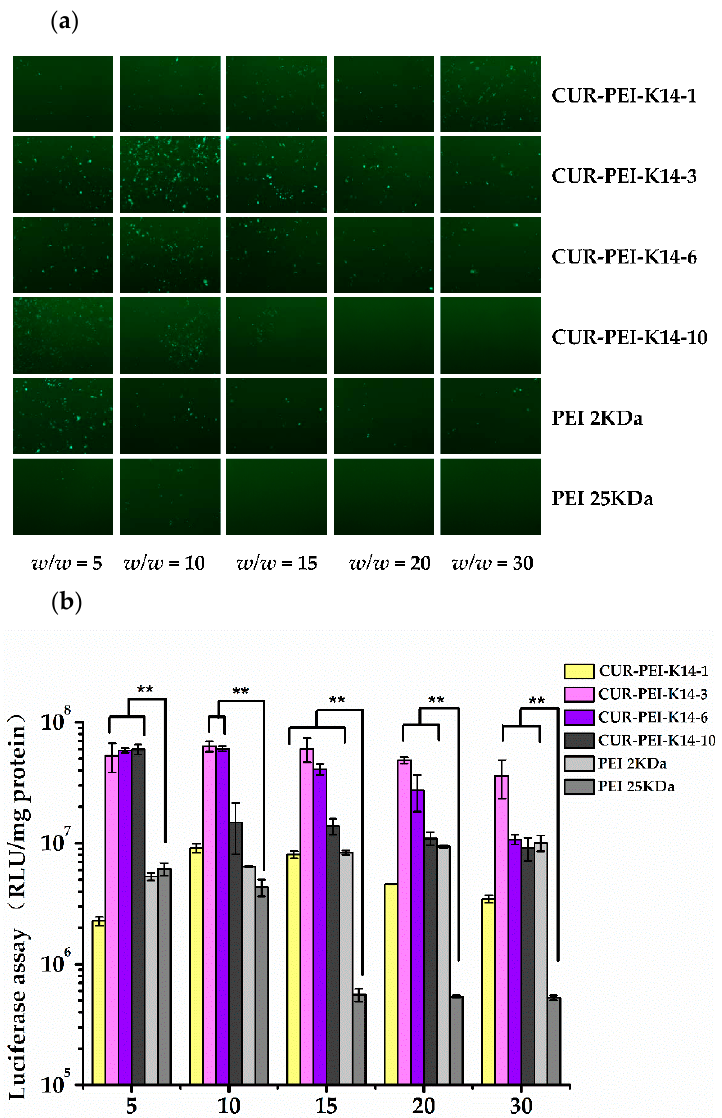
Figure 6. Transfection efficiency of ( a ) pEGFP-N2 and ( b ) pGL3-Control in SKOV3-DDP cells by different polymer/DNA complexes at w / w ratios of 5, 10, 15, 20, and 30. Each data point represents the mean ± standard deviation ( n = 3, ** P < 0.01). pEGFP-N2 is a reporter gene that can be used to qualitative analyze transfection efficiency; pGL3-Control is a reporter gene that can be used to quantitatively analyze transfection efficiency.